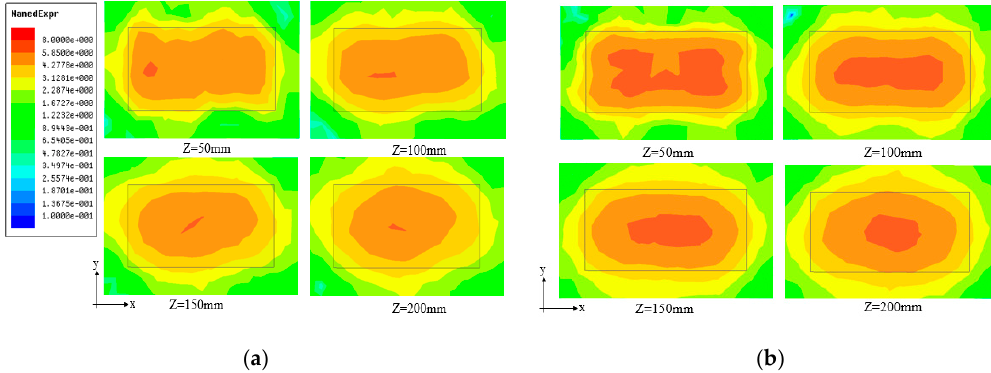
Figure 28. Simulated distribution of electric field components (Ex, Ey) at different heights for a 2 × 4 array antenna: ( a ) Ex distribution and ( b ) Ey distribution.